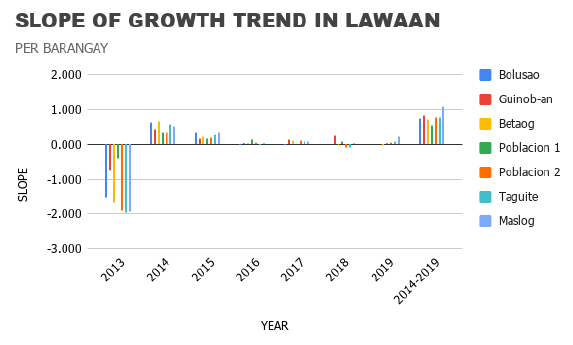
Figure 10. Bar graph showing the comparison of slopes per barangay in Lawaan